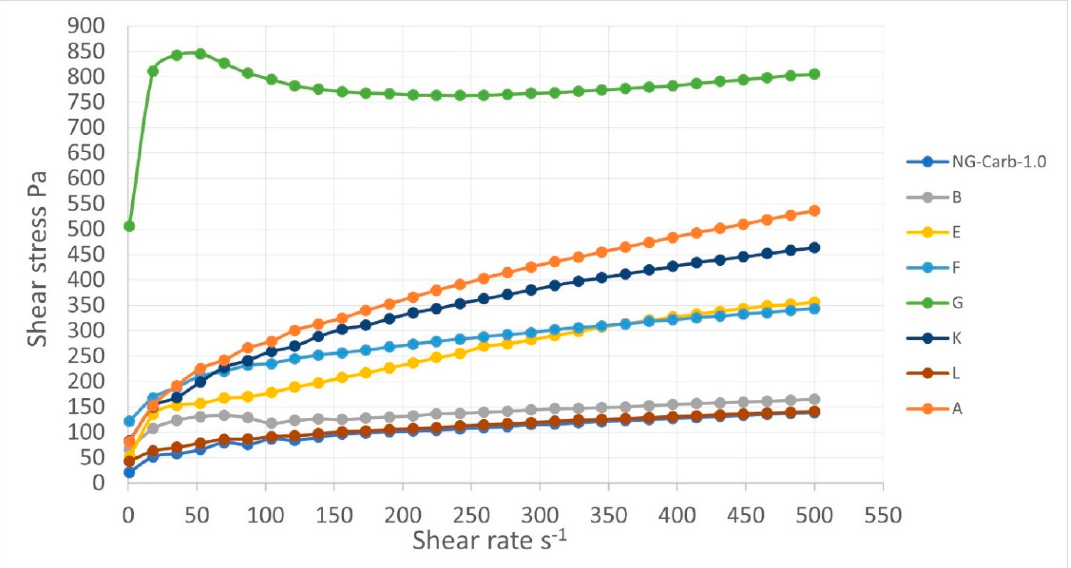
Processes 2020 , 8 , x FOR PEER REVIEW Figure 2. Flow curves of samples belonging to a physicochemical form group–emulsions.